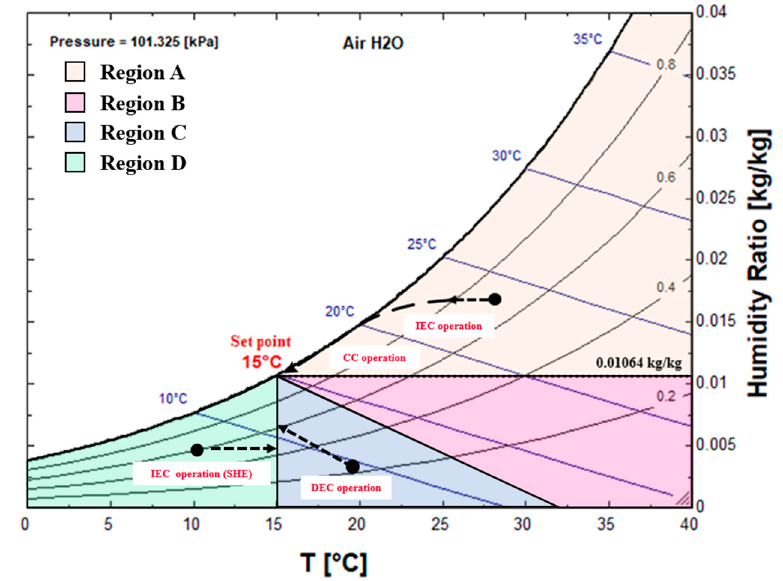
Figure 5. The operating modes for IDECOAS depicted on a psychrometric chart.